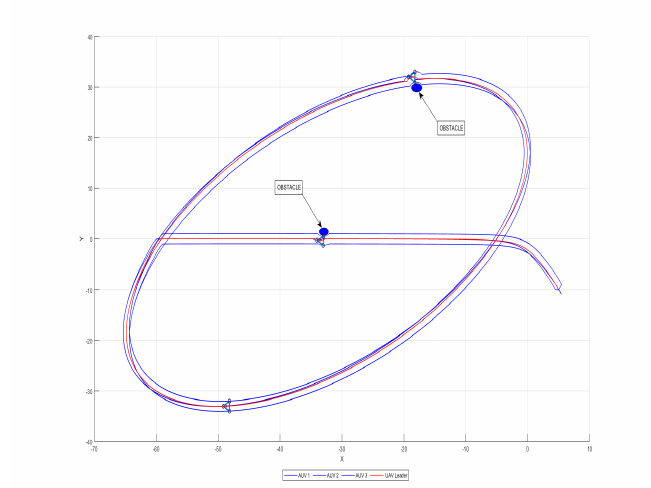
Figure 6. The formation maintenace and control of three AUVs in triangle form with their UAVs leader during obstacle avoidance in 2D space.